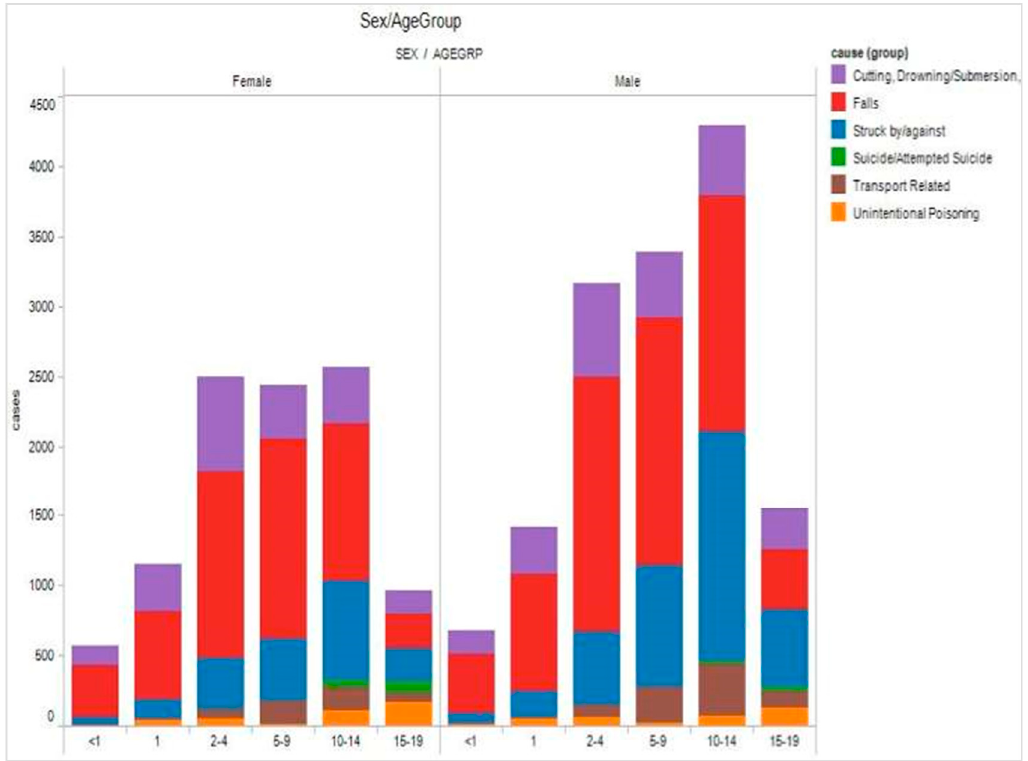
Figure 2. Details-on-demand (sex/age/injury cause).